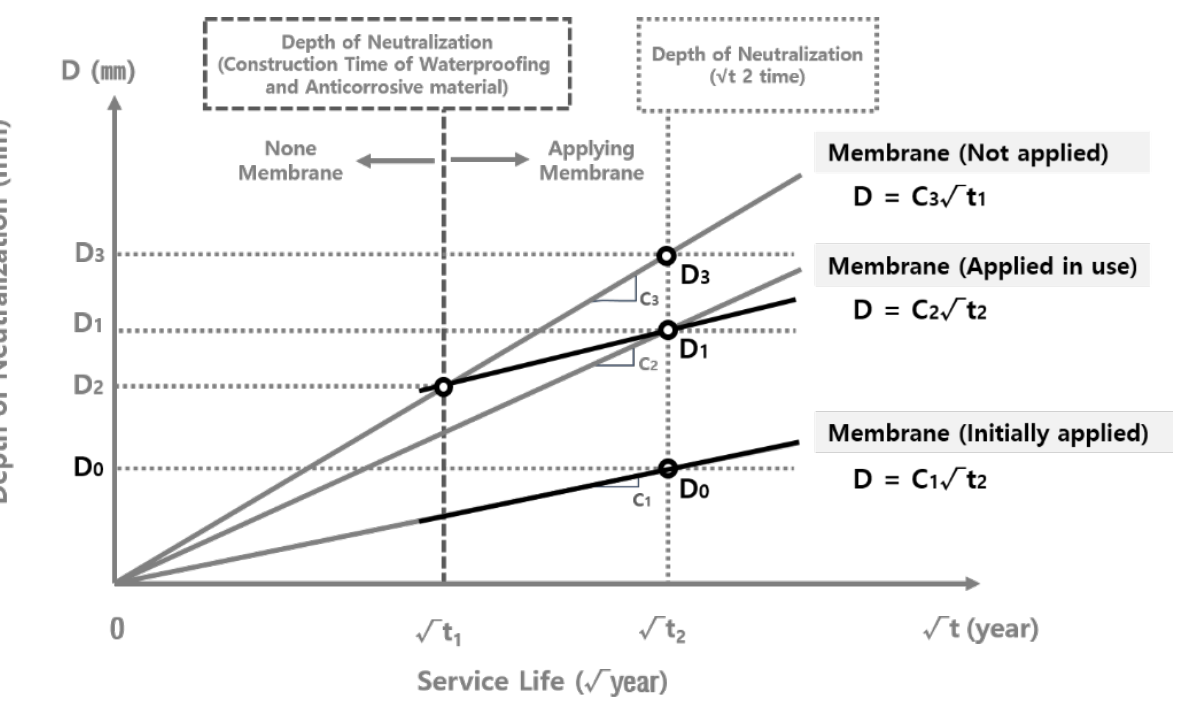
Figure 3. Schematic diagram of correlation between the carbonation rate coefficient and the application of the waterproofing/anticorrosive method.